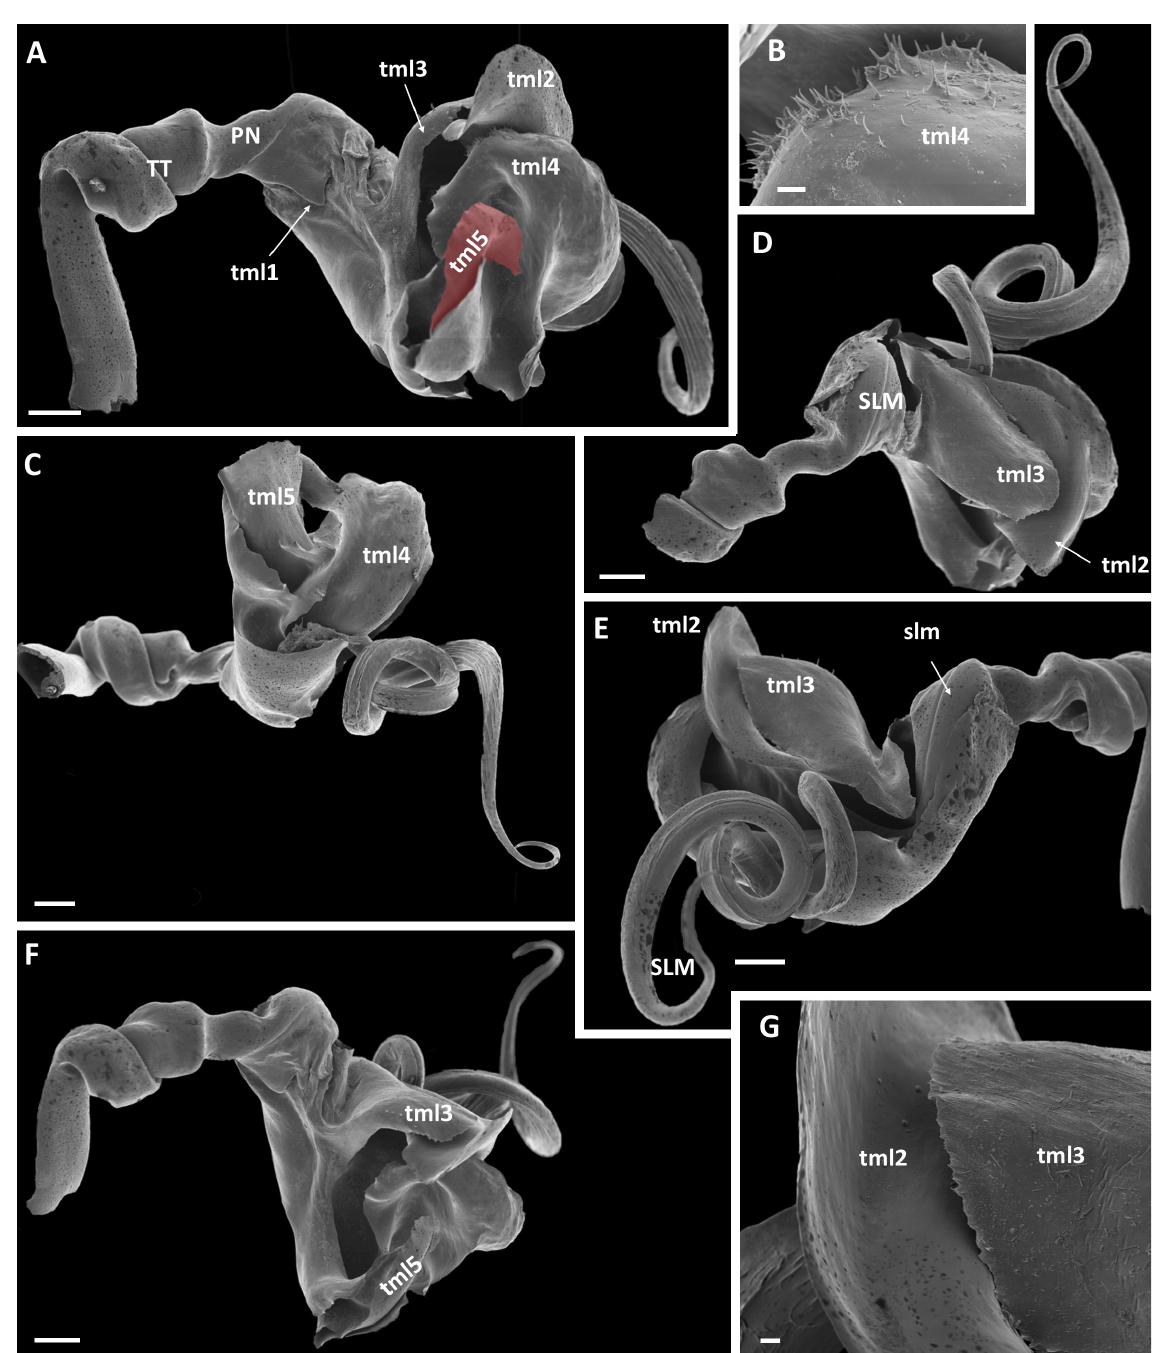
Fig. 30. Chaleponcus schioetzae sp. nov., holotype, ♂ (NHMD 621725), left gonopod telepodite. A . Anterior view, tml5 highlighted . B . Close-up of microtrichose area of tml4 . C . Basal (dorsal) view. D . Distal (ventral) view. E . Posterior view. F . Anterior-ventral view. G . Close-up of tml2 and tml3 . Abbreviations: PN = post-torsal narrowing; SLM = solenomere; tml1 -5 = telomeral lobes; TT = torsotope. Scale bars: A, C–F = 0.1 mm; B, G = 0.01